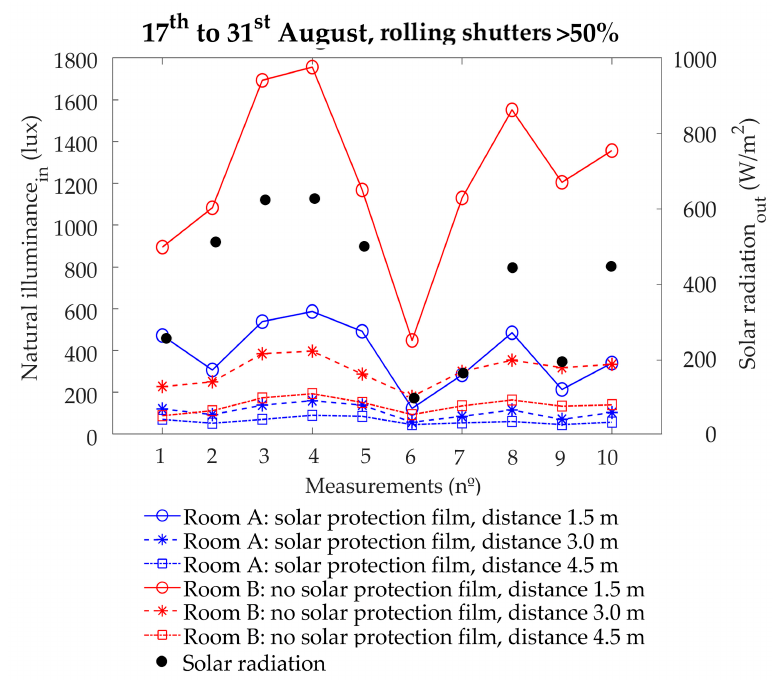
Figure 8. Incident solar radiation and indoor natural illuminance recorded in the room without solar film (red points) and with solar film (blue points), according to the distance between the luxmeter and the window. Summer period. Source: Authors.